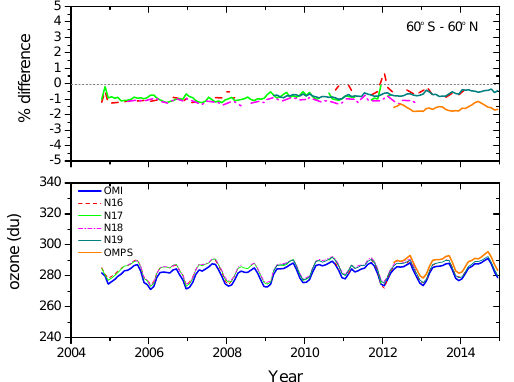
Figure 6. The OMI ozone time series averaged over the zone 60 ◦ S to 60 ◦ N is compared with ozone from four SBUV/2 instruments on NOAA satellites and with the OMPS mapper on Suomi NPP.